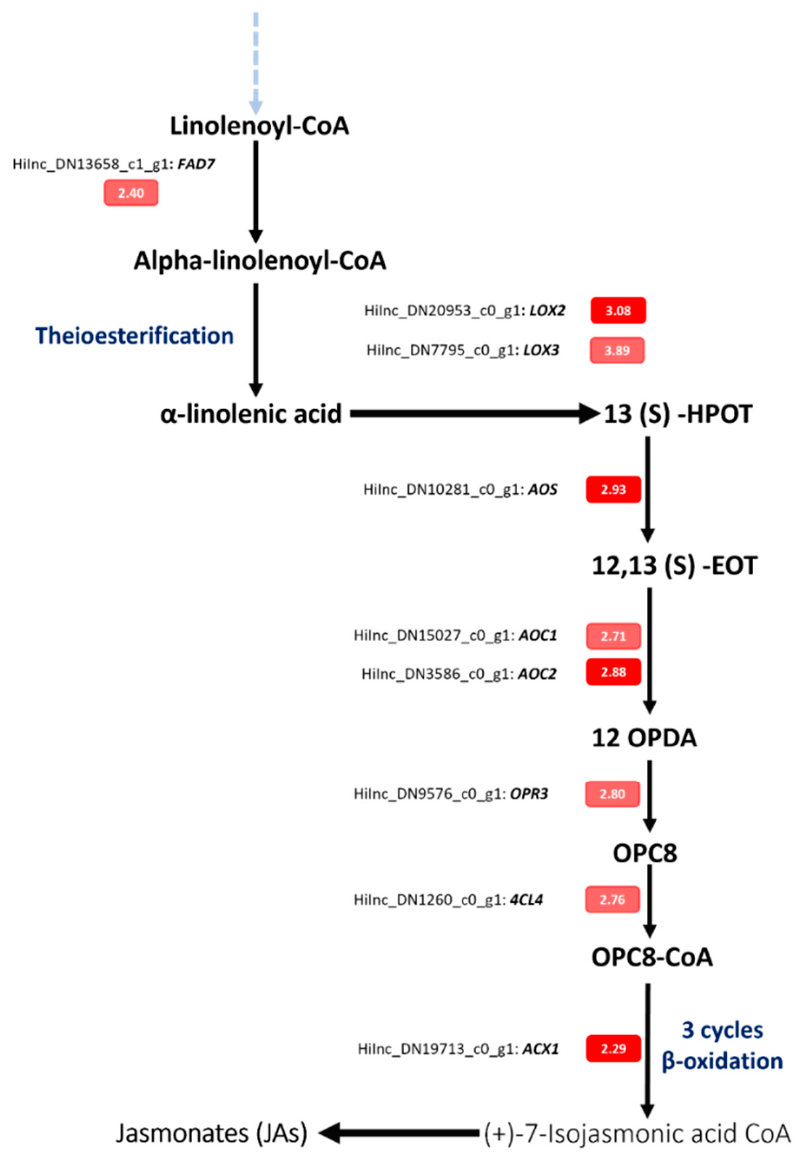
Figure 6. Expression level of genes implicated in the JAs biosynthesis pathways in H. incana under Pb exposure. The red color represents the genes selected using the restrictive method “Bonferroni”, and the light red represent the genes selected without using the restrictive method .